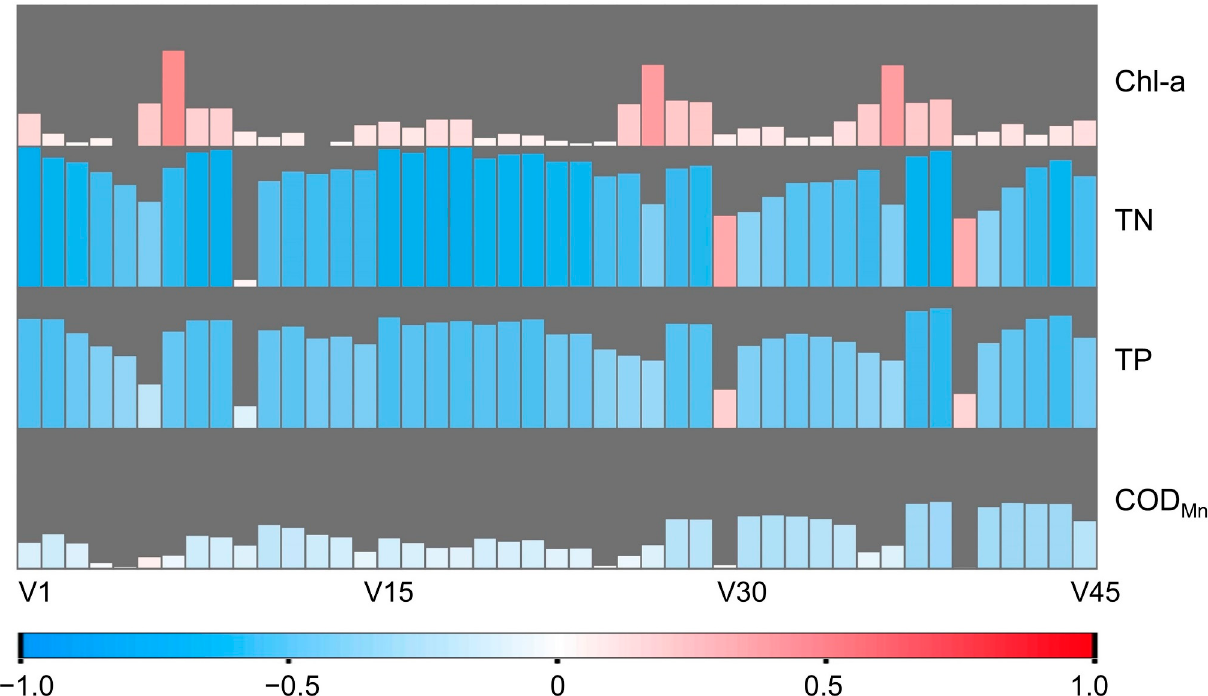
Figure 5. The correlation between spectral index and water quality parameters.